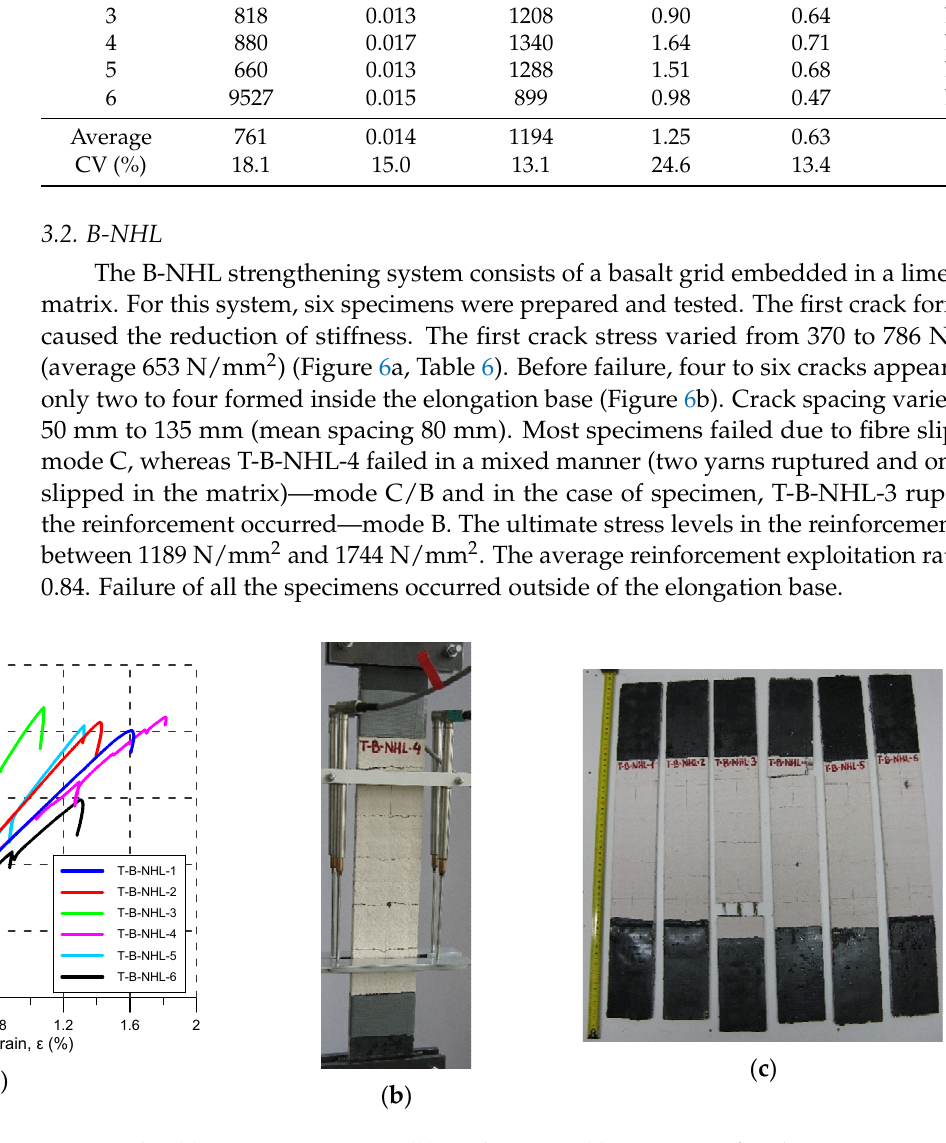
Figure 6. B-NHL test results: ( a ) stress-strain curves; ( b ) crack pattern; ( c ) specimens after the test. Table 6. B-NHL test results.